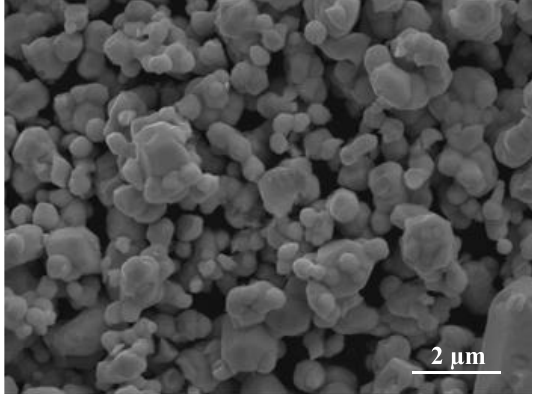
Figure 1. SEM image of Ag 2 O microparticles.